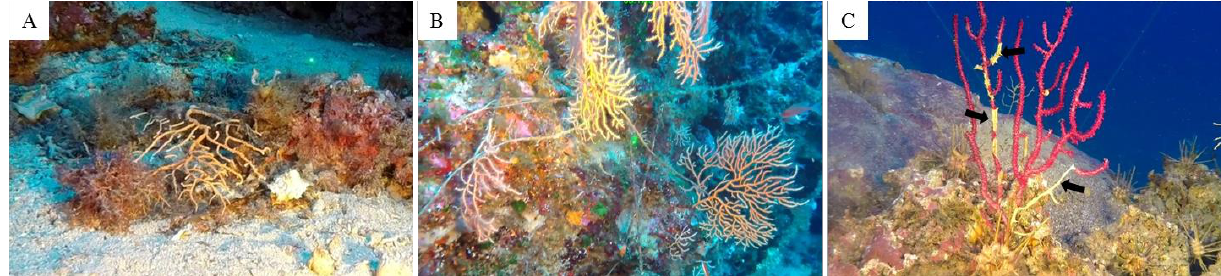
Figure 9. Examples of BUC (broken/upturned colonies, ( A )), GCE (gears covering/entangling, ( B )), and CNE (colonies with necrosis/epibiosis, ( C )), black arrows show the necrotic parts).